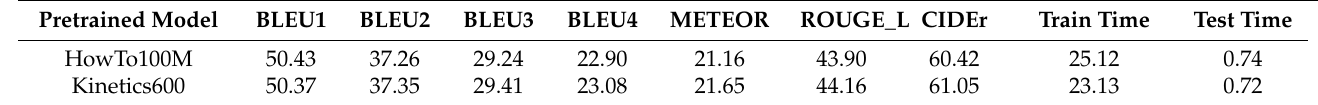
Table 5. Results of changing the video backbone model.